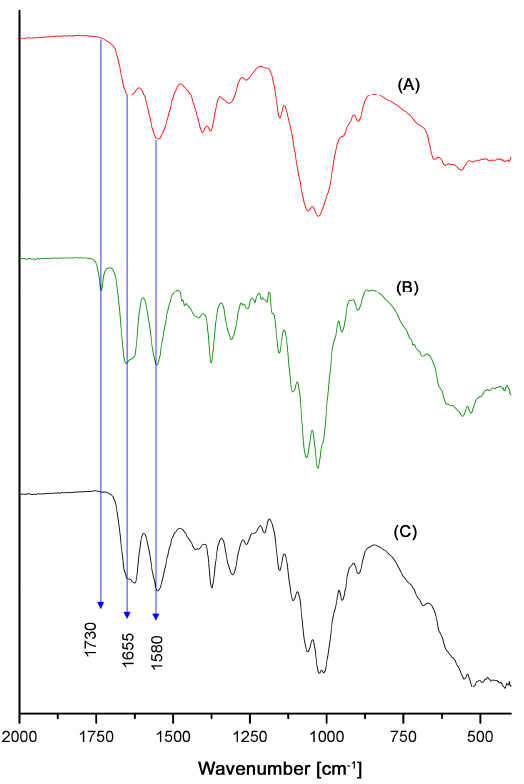
Figure 5. FT-IR-ATR spectra for chitosan Q24 ( A ), O-acetylated and N-acetylated chitosan ( B ) and N-acetylated chitosan ( C ).